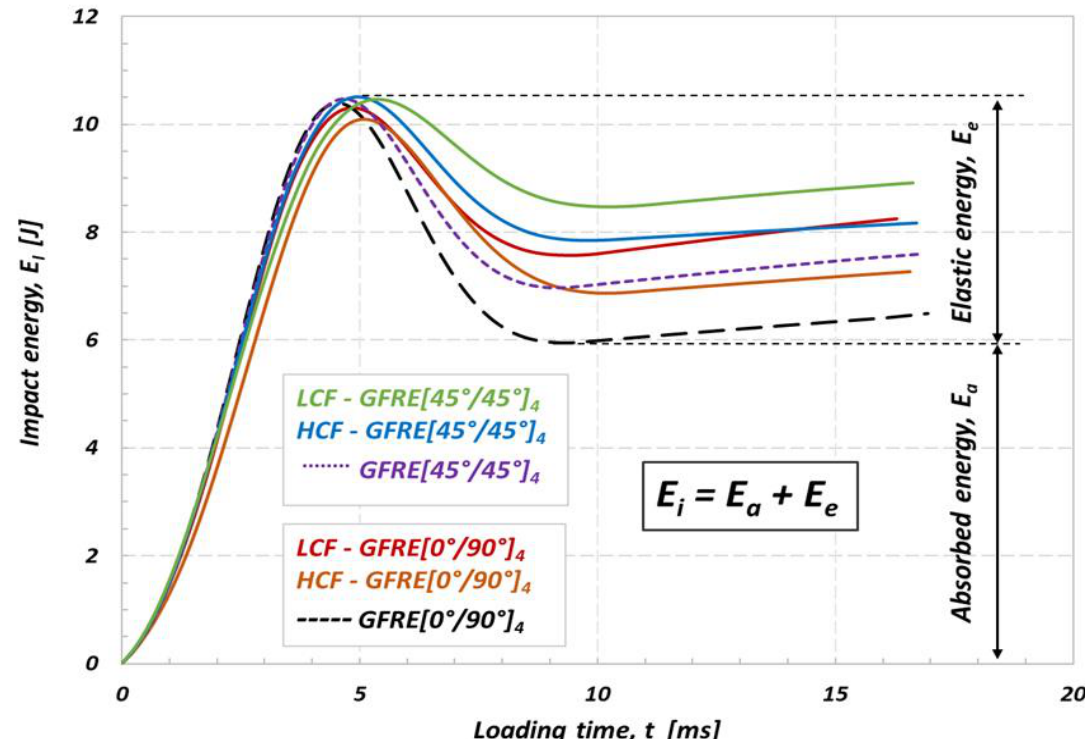
Figure 10. Effect of fatigue aging on the absorbed energy of the non-aged and aged GFRE for impact energy equal to 10 J at 20 °C.